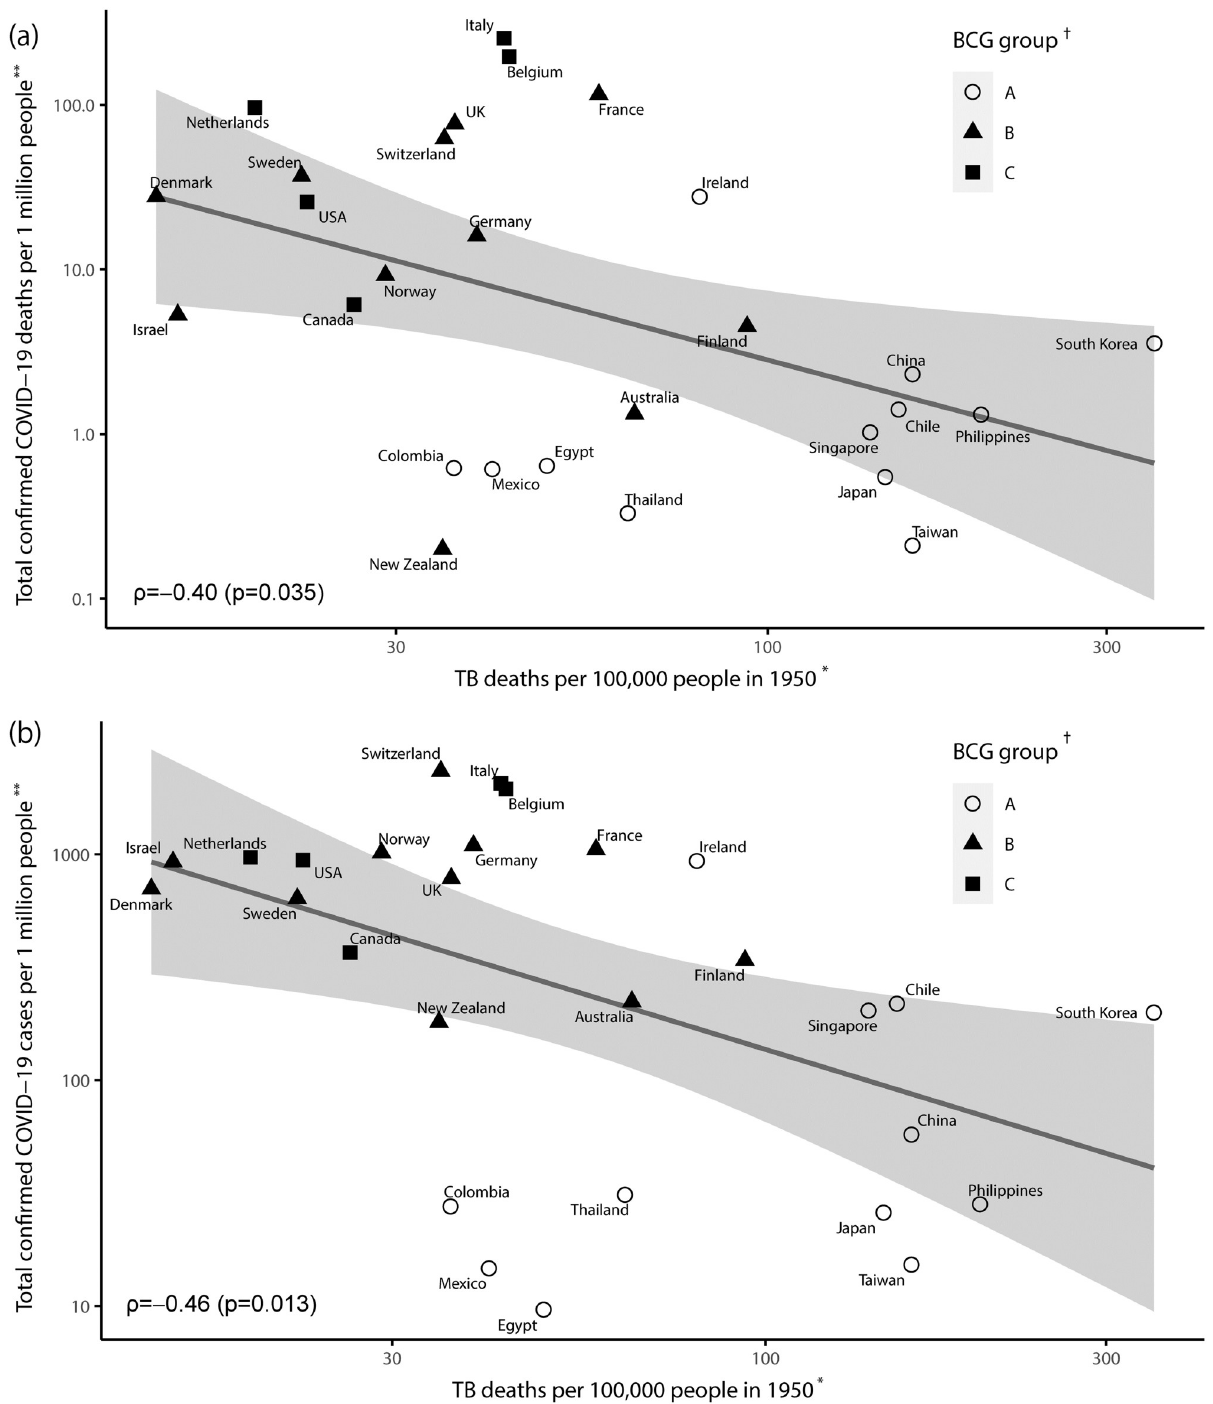
Fig 4. Scatterplot of the mortality rate of tuberculosis (TB) in 1950 versus (a) cumulative mortality rate of COVID-19 and (b) the cumulative incidence rate of COVID-19 on 5 April 2020, according to BCG vaccination status among 28 countries. � Information was obtained